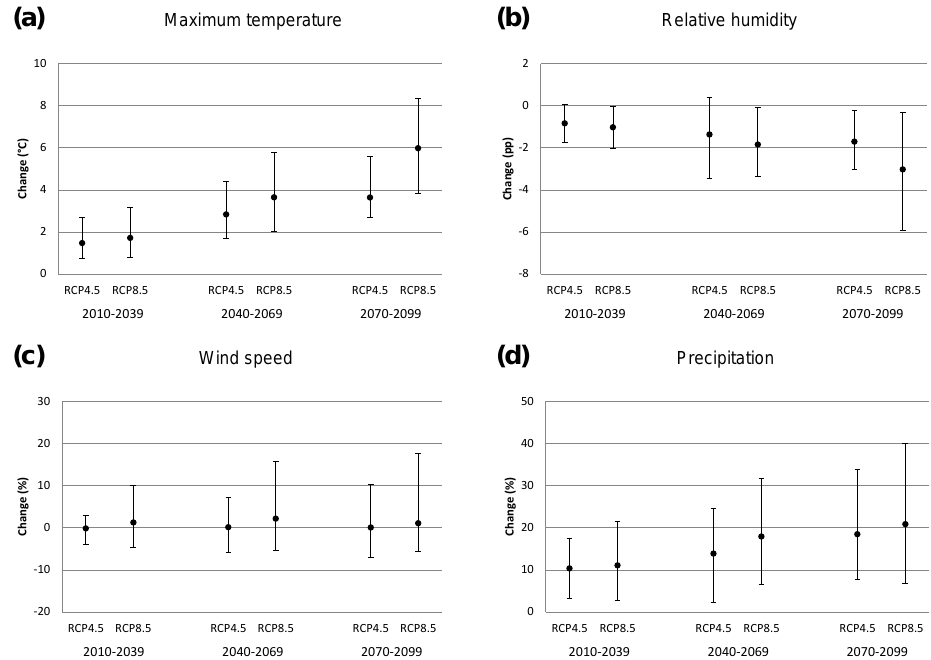
Figure 2. Projected changes in April–October mean daily maximum air temperature at 2m (a) , daily average relative humidity at 2m (b) , daily average wind speed at 10m (c) , and total precipitation (d) compared to the period 1980–2009 and averaged over the whole of Finland. Dots indicate the multi-model mean change and whiskers extend to the maximum and minimum